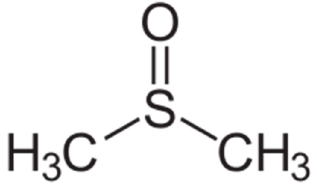
Figure 1. Molecular structure of DMSO.